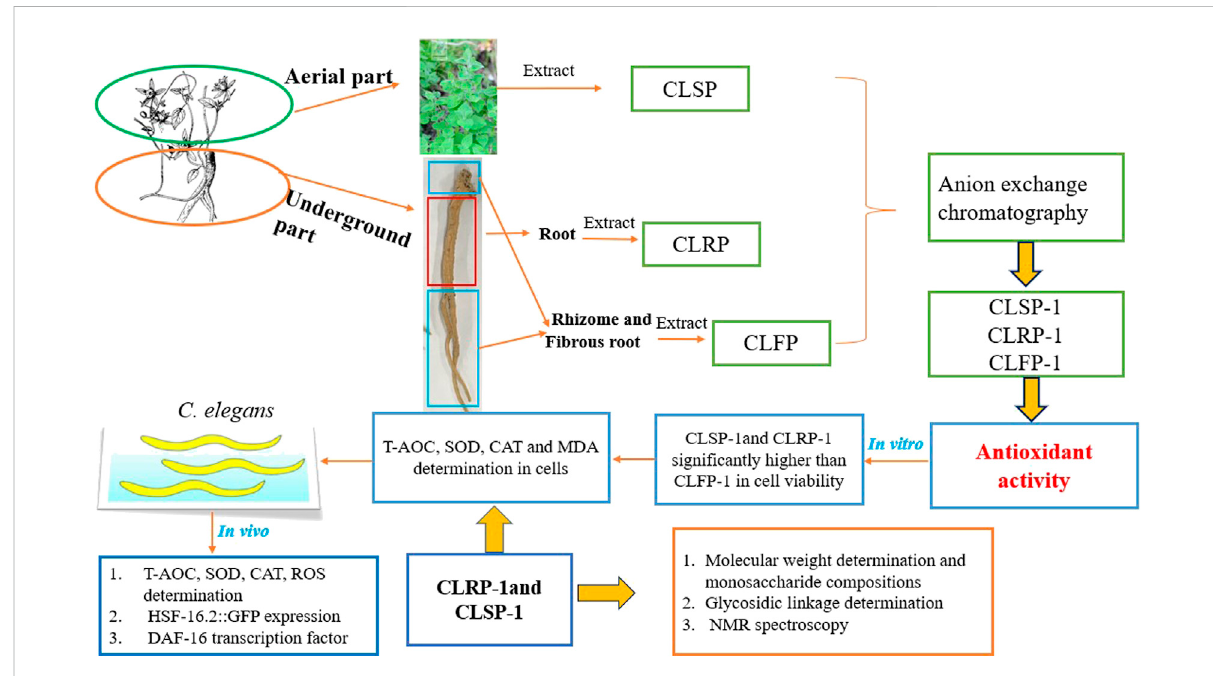
FIGURE 1 Schematic diagram of extraction, puri fi cation, structural characterization, and antioxidant activities of different parts of C . pilosula Nannf. var. Modesta (Nannf.) L. T. Shen.